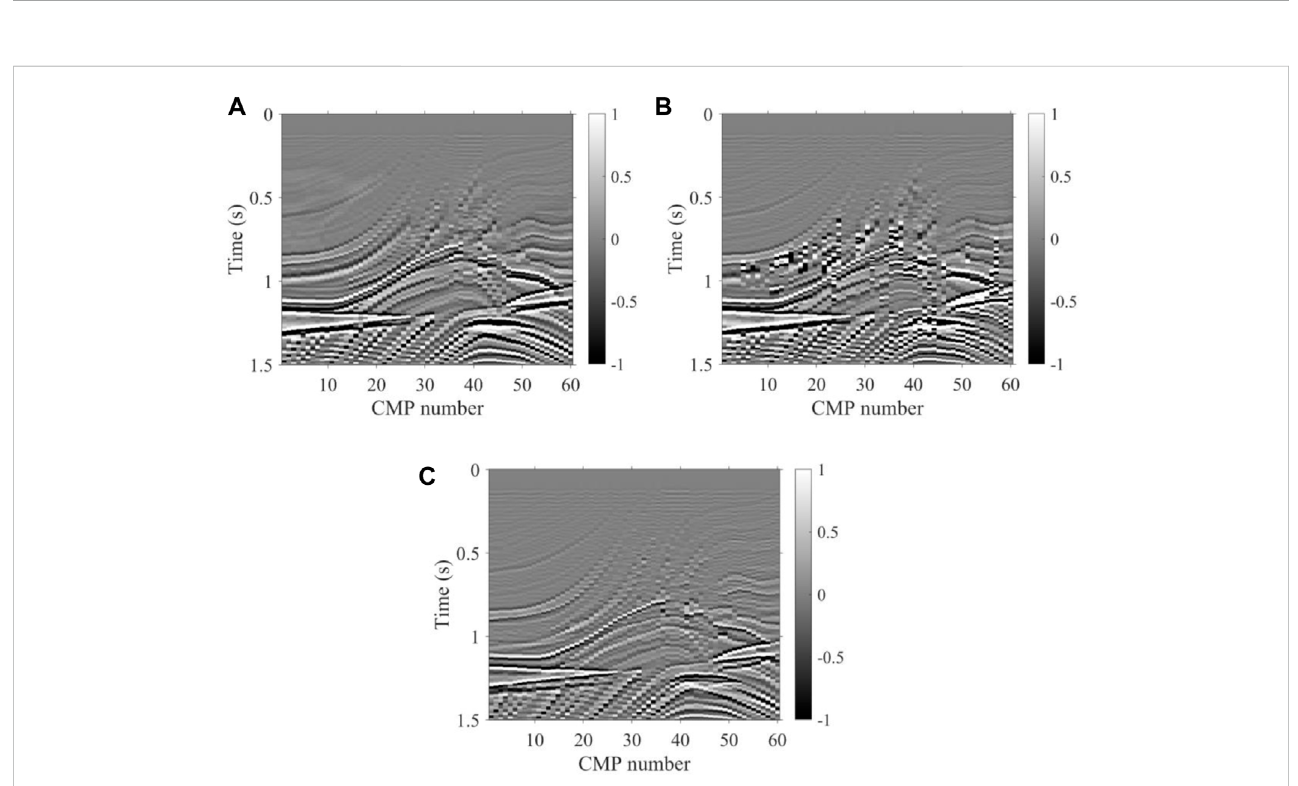
FIGURE 11 Stacking pro fi les of synthetic data with random noise and strong energy regular noise. (A) True velocity, (B) velocity of K-means, and (C) velocity of the method proposed.